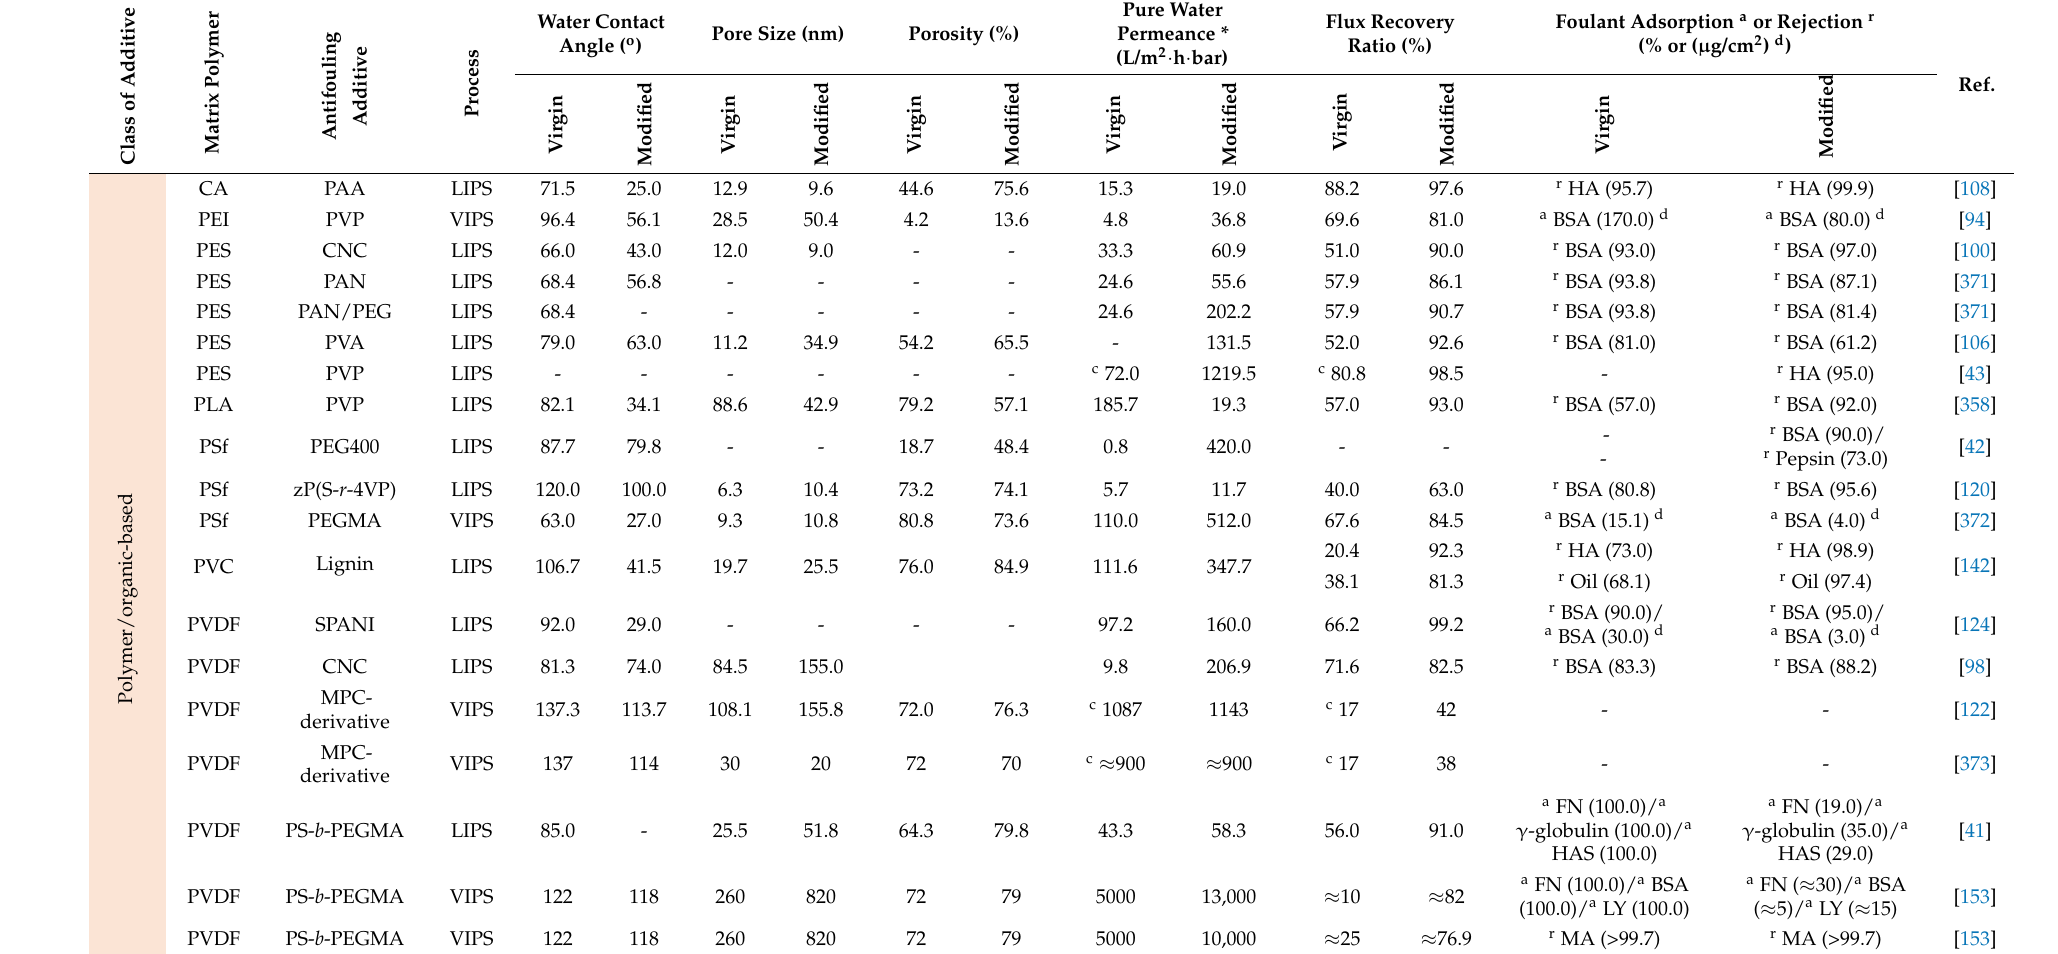
Table 5. Some performances of blending modified membranes reported in the past